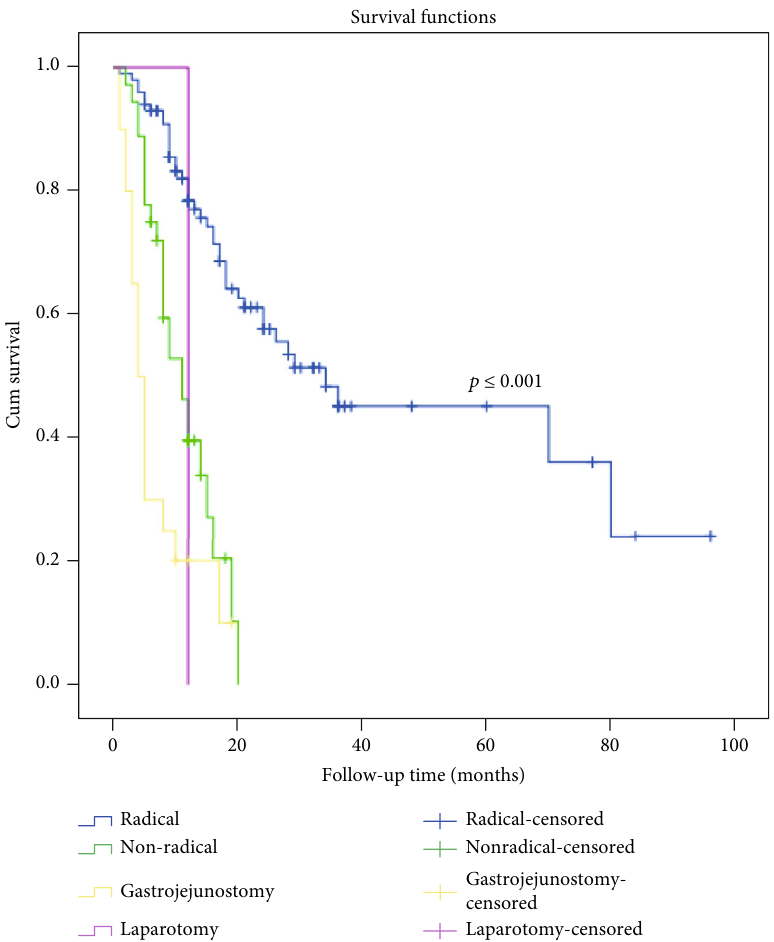
Figure 2: Survival curves for the 157 gastric cancer patients with GOO according to surgical procedure ( p ≤ 0 : 001